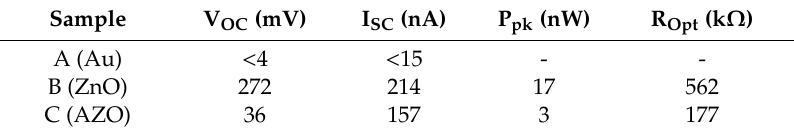
Table 3. Electrical performances of the PENGs depending on their seed